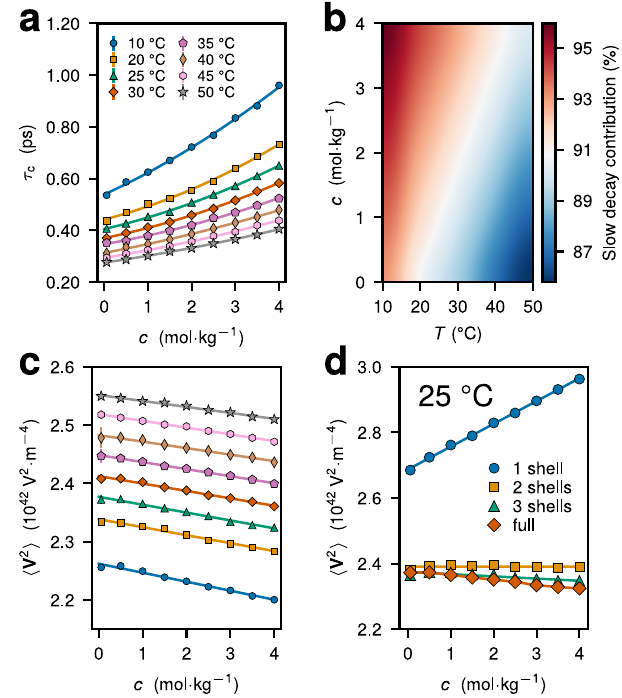
Fig. 4 | Microscopic parameters of the EFG relaxation. a Effective correlation time τ c oftheEFG fl uctuationsattheNa + positionasafunctionofsaltconcentration c for different temperatures T . b Relative contribution of the slow EFG relaxation modeto τ c fordifferent c and T .Thecontributionwasestimatedusingthestretched exponential fi t of the normalized EFG ACFs (Supplementary Note 9). c Variance of the total EFG at the ion position h V 2 i = ð 1+ γ 0 eff,0 Þ 2 h V 2 ext i as a function of c for dif- ferent temperatures. The legend in c is the same as in a . d EFG variance, 〈 V 2 〉 , evaluated from water molecules and ions located within a different number of solvation shells around the central Na + ion as a function of c at T =25°C. The standard error from multiple independent simulation runs is either explicitly shown or does not exceed the symbol size.